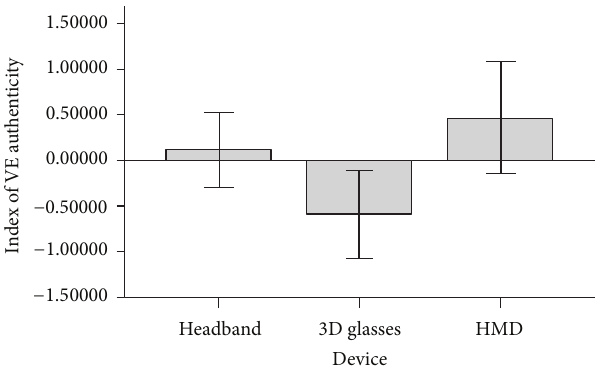
Figure 4: The mean of the standardized VE authenticity index between the devices. The lines represent 95% confidence